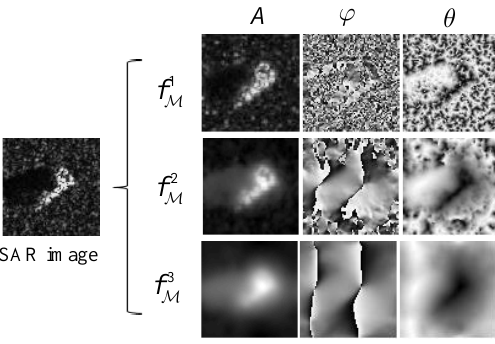
Figure 2. The example of monogenic components with SAR